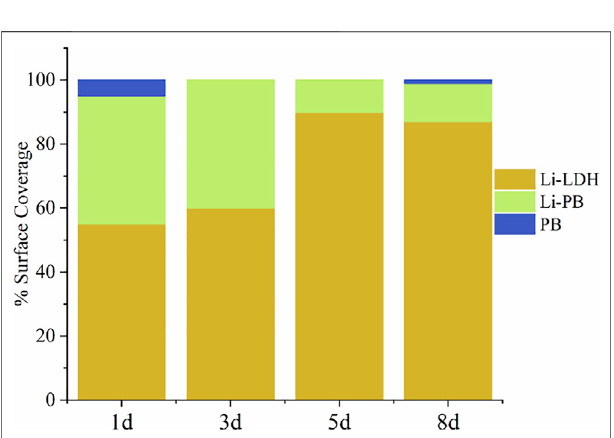
FIGURE 10 | Surface coverage percentage of PB, Li – PB, and Li-LDH derived from 3D images.